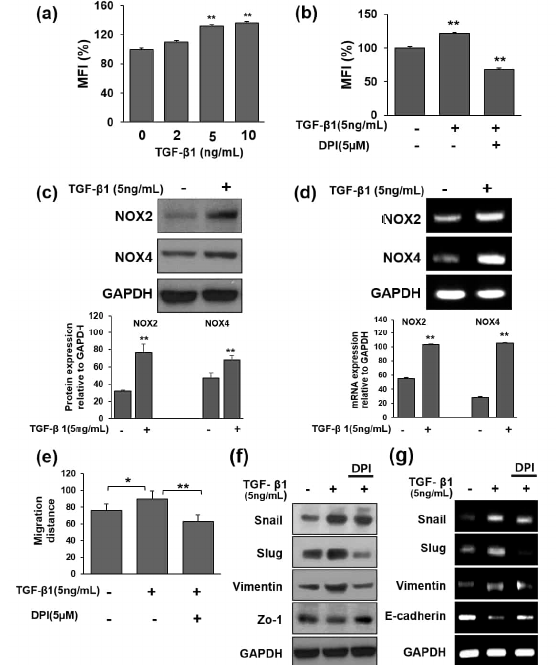
Figure 1. Transforming growth factor- β 1 (TGF- β 1) induces NOX2 and NOX4-dependent reactive oxygen species (ROS) generation in HeLa cells. ( a ) ROS levels in treated HeLa cells were measured